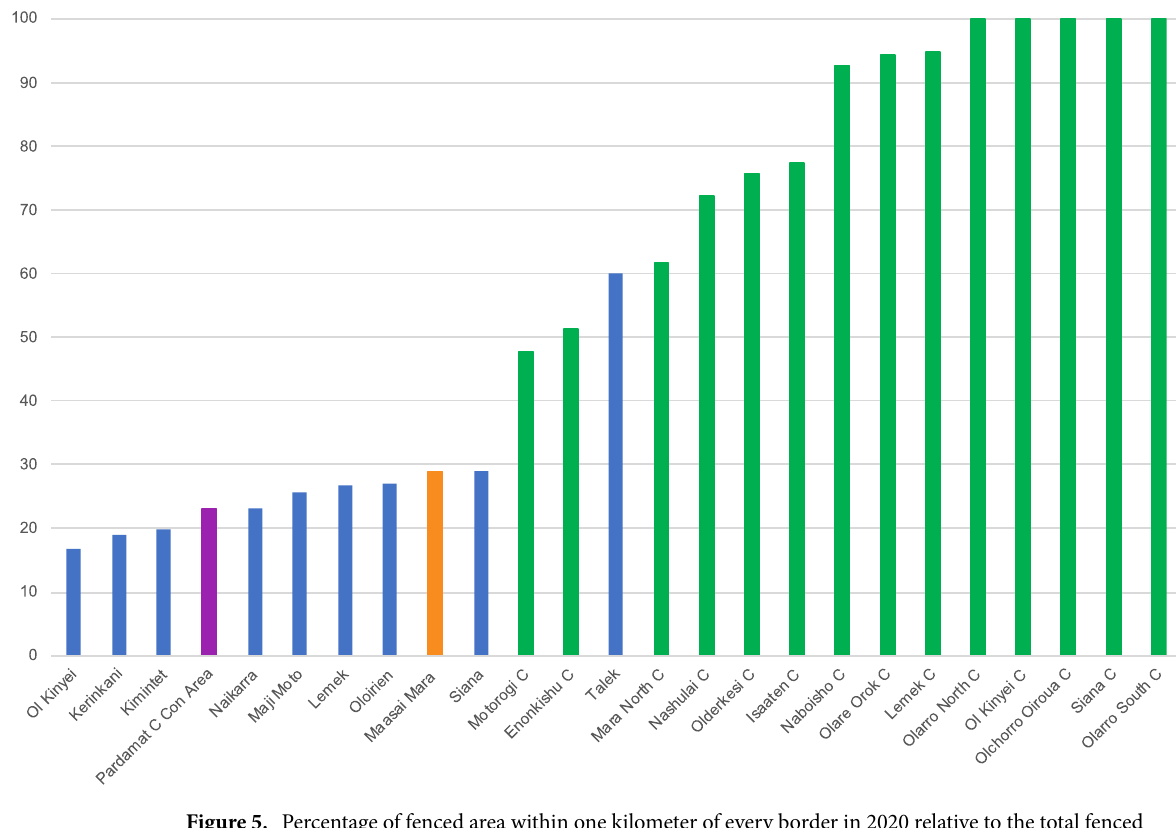
Figure 5. Percentage of fenced area within one kilometer of every border in 2020 relative to the total fenced area of each region of the Greater Mara. Green bars are conservancy areas, the orange bar is the national reserve, the purple bar is the conservation area, and the blue bars are remaining (formally unprotected) regions. The size of the regions is not taken into account in this figure.